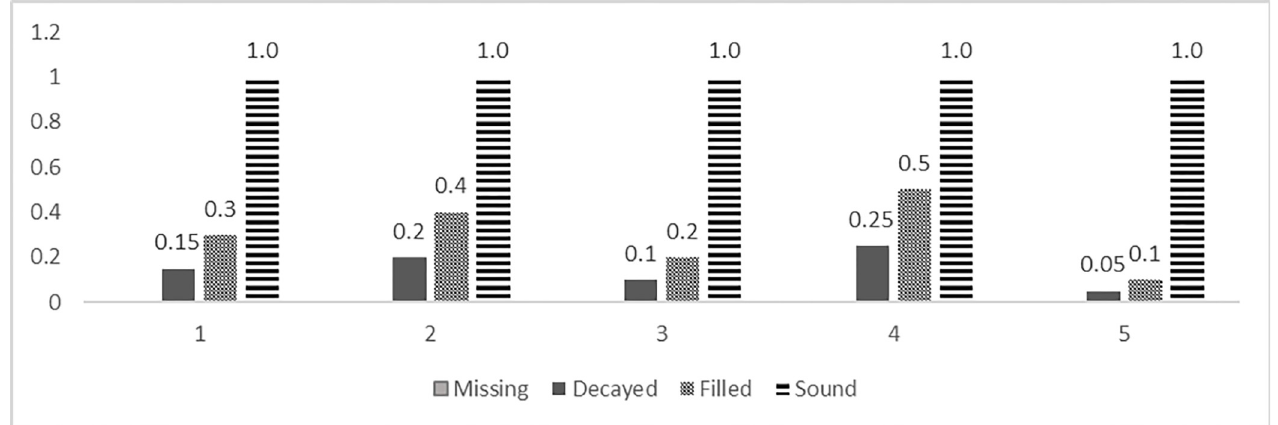
Fig 2. Five measures of the T-Health Index � . Note: � This study used the T-Health index of Bernabe´ et al. [19].